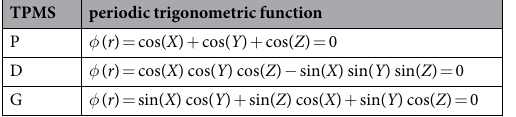
Table 1. Some simple TPMS models constructed by trigonometric